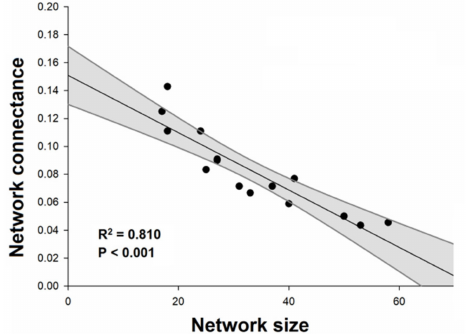
Figure 4. E ff ects of network size on the network connectance of plant–galling insect networks in Brazilian Cerrado. Occurrence of superhost plants is an ordinal variable of occurrence of Qualea species (number of species) to each network. Black points represent di ff erent plant–galling insect networks. Gray bands represent the model’s 95% confidence